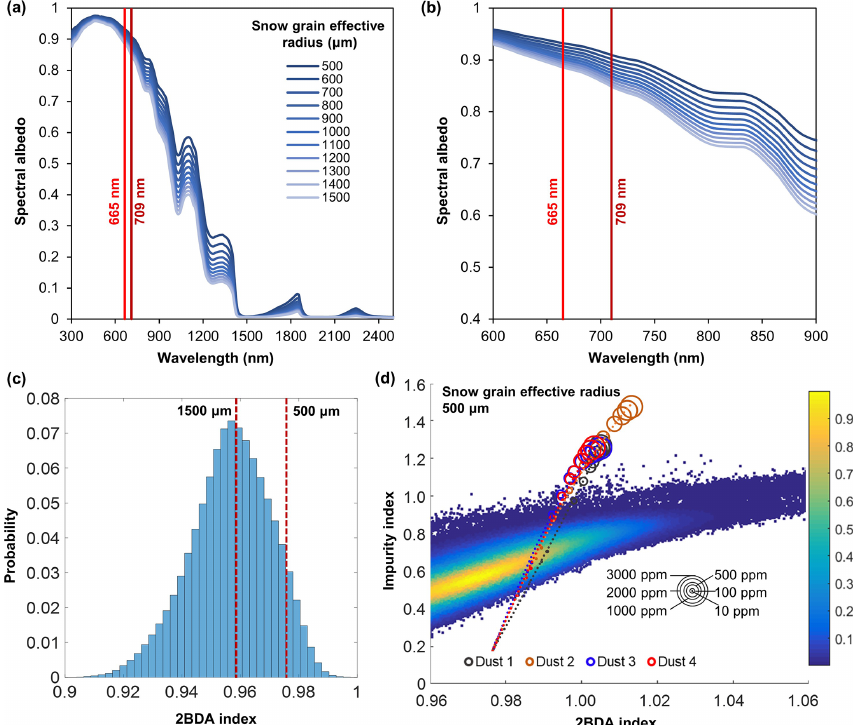
Figure A1. (a) SNICAR dust-free simulations for different snow grain sizes (500–1500µm). (b) Zoomed-in graph of (a) showing details of spectral albedo values at 665 and 709nm. (c) Histogram of the 2BDA index for MERIS bare ice pixels with 620nm reflectance greater than 0.65 (clean ice) and the corresponding 2BDA values for the SNICAR dust-free simulations with snow grain size of 500 and 1500µm. (d) Impurity index vs. 2BDA index for MERIS bare ice pixels (density scatterplot with colors indicating relative frequency) and for SNICAR simulations (circles and dashed lines) with snow grain size of 500µm for varying concentrations of dust (four different dust sizes). The circle size corresponds to the dust concentration, and dashed lines show the polynomial regression for each of the different dust sizes.